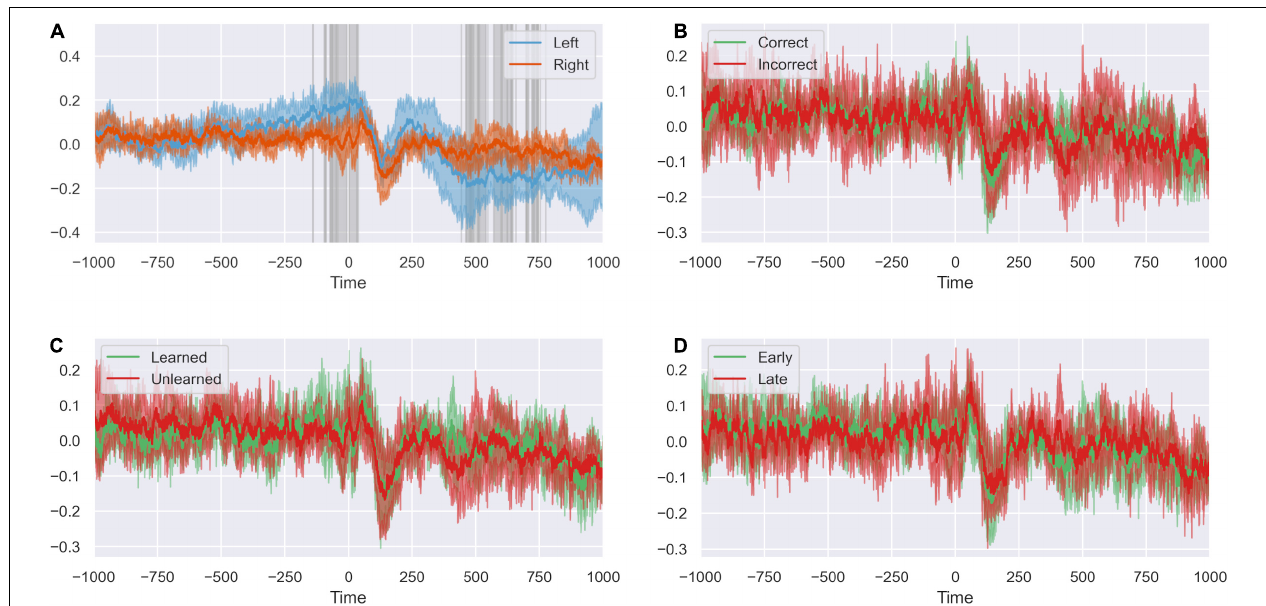
FIGURE 8 | The peri-stimulus response is not modified by task variables. (A) Response of left and right ACC time-locked to stimulus presentation. Highlighted regions show where activity differs between sides. There is event of peri-stimulus activity in the ACC. Differences in activity between sides indicates lateralization of the stimulus response. (B) The peri-stimulus response of the ACC when the previous trial was correct and incorrect. The outcome of the previous trial does not appear to influence the stimulus response on subsequent trials. (C) The peri-stimulus response of the ACC when the task has been learned or unlearned. Whether the present task has been learned does not appear to influence the stimulus response. (D) The peri-stimulus response of the ACC for early and late trials. The peri-stimulus response does not appear to differ between early and late trials.